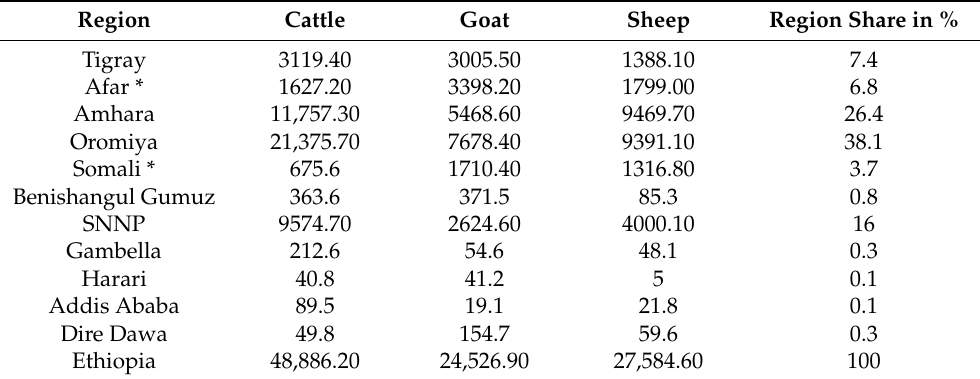
Table 1. Livestock population by region (thousands) in Ethiopia.